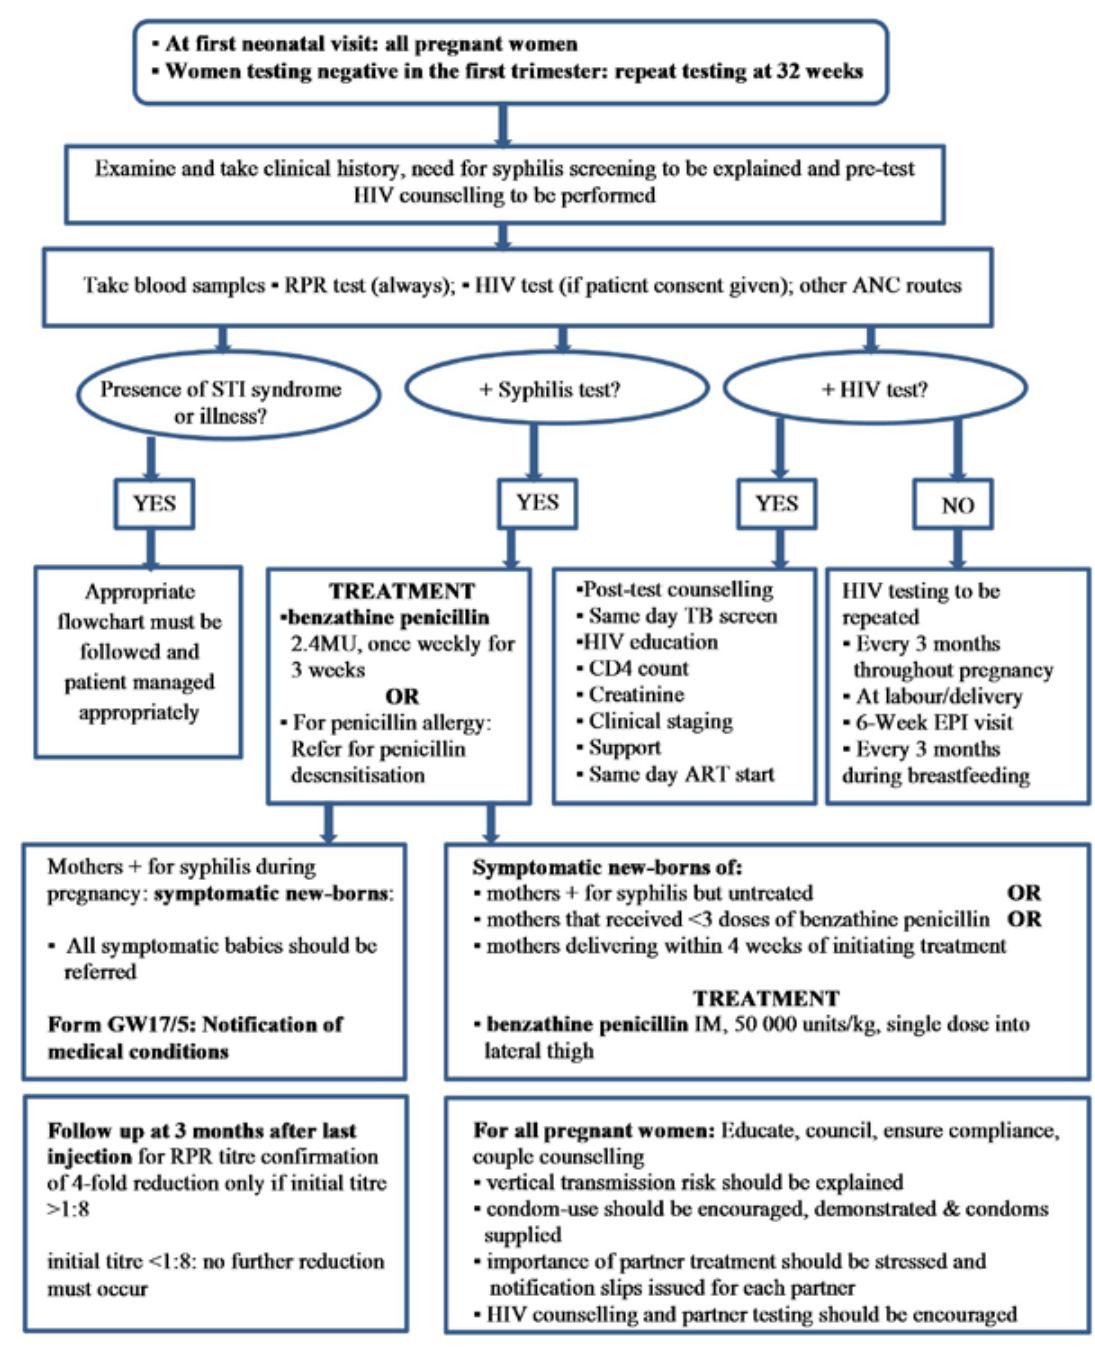
Figure 9: Flowchart of syndromic treatment of syphilis in pregnant women. (adapted from the revised syphilis (pregnancy) flowchart of the Primary Health Care Standard Treatment Guidelines and Essential Drugs List, 2015)